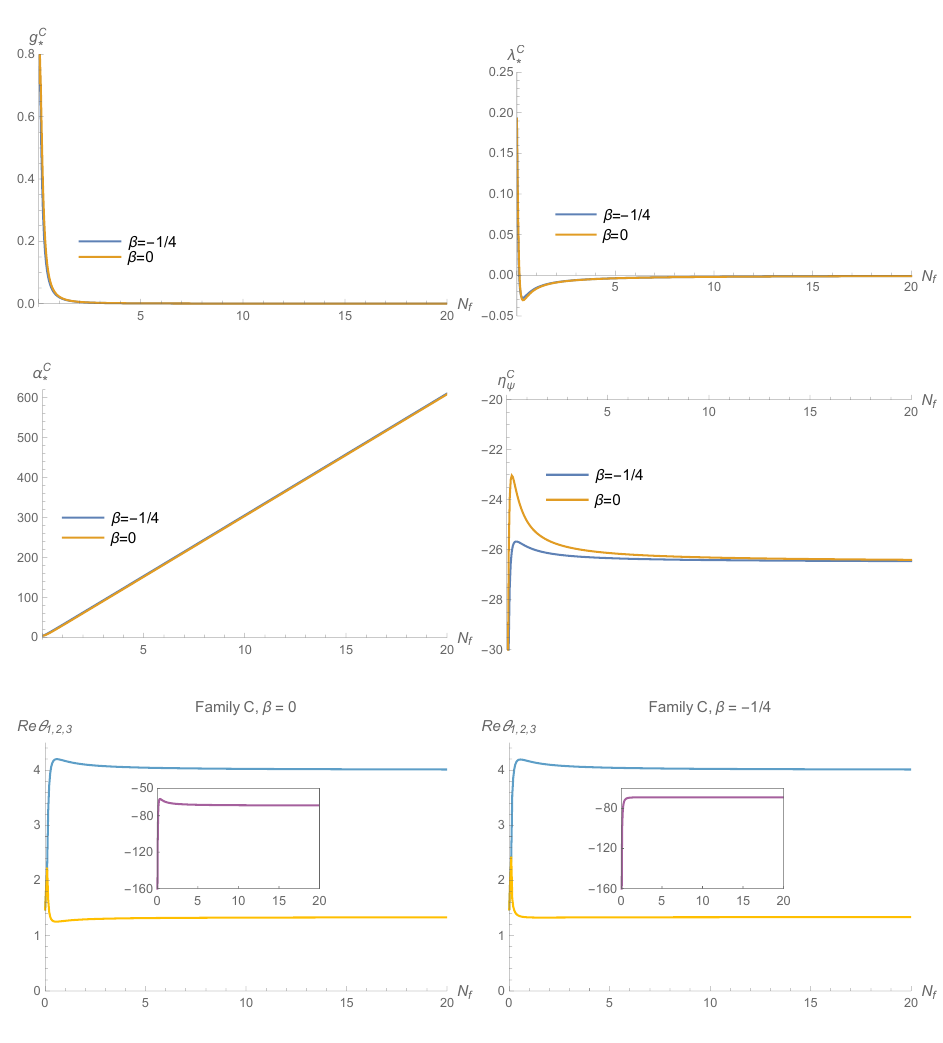
Figure 14. Characteristic properties of Family C obtained from investigating the system Equations (26) and (29) with A 0 = 0. The first three diagrams show the position of the fixed points as a function of N f for β = − 1/4 (blue line) and β = 0 (orange line). NGFP C exists for all values N f and is fairly insensitive to the choice of β . The fermion anomalous dimension at the fixed points is depicted in the fourth diagram, showing that it is negative and rather large. The stability analysis identifies two UV-attractive and one UV-repulsive stability coefficient, indicating that NGFP C is a saddle point in the { g , λ , α }